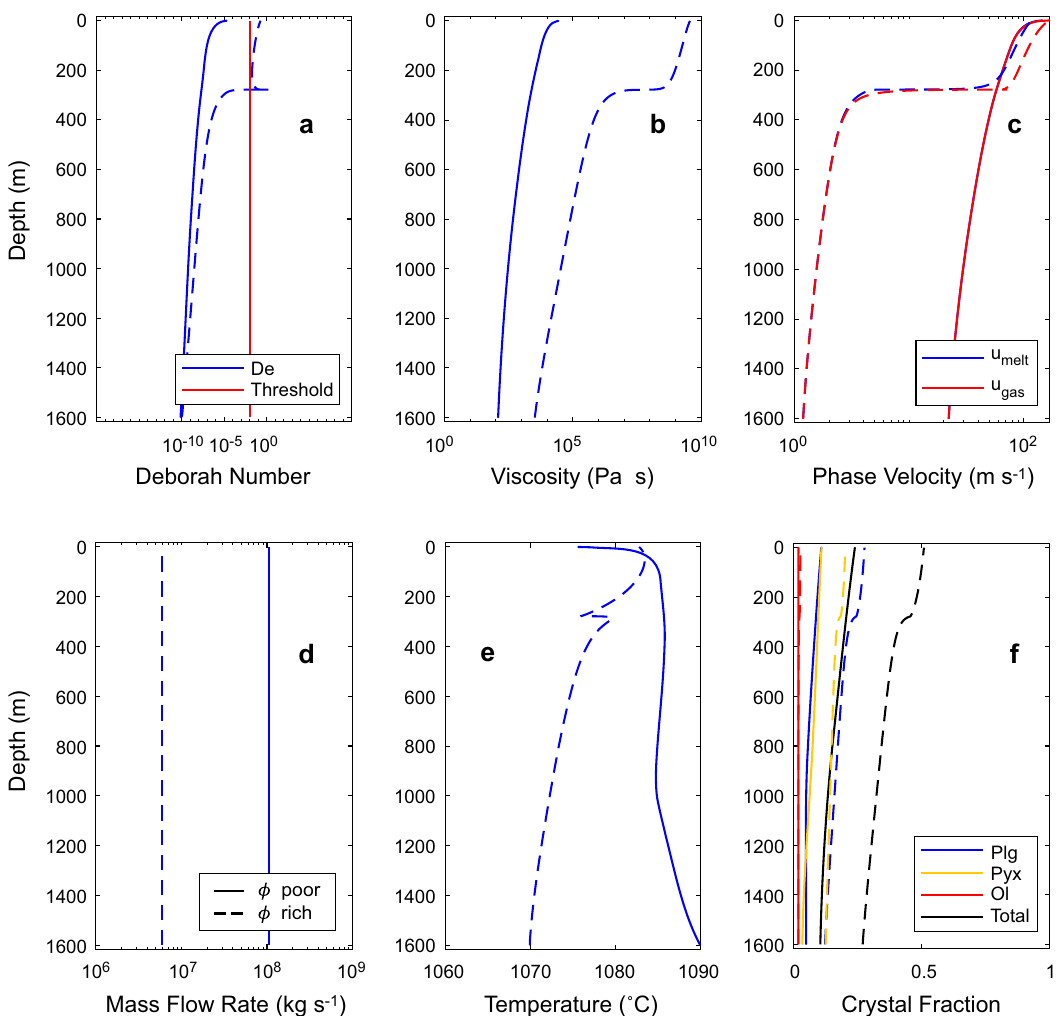
Fig. 7 Numerical solutions using the conduit model for the Masaya Triple Layer eruption. Results for the crystal-poor endmember are indicated by solid lines, and results for the crystal-rich endmember are highlighted by dashed lines. ( a ) Deborah number, ( b ) viscosity, ( c ) phase velocity ( u ), ( d ) mass fl ow rate, ( e ) temperature and ( f ) crystal fraction. For ( c ), u melt and u gas overlap until fragmentation occurs as the gas and melt phases are coupled and ascend with the same velocity. For the crystal-poor endmember u melt and u gas continue to overlap as fragmentation does not occur. For the crystal-rich simulation, the Deborah number is reached at ~280 m below the vent and magma fragmentation occurs. The increase in crystal fraction and consequently magma viscosity during magma ascent leads to fragmentation for the crystal-rich simulation. Both simulations have an initial depth of 1600 m, corresponding to the depth of the magma